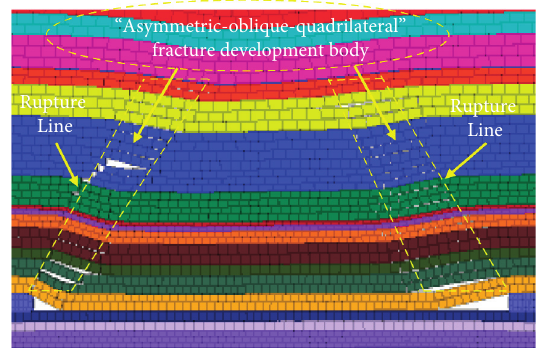
Figure 12: Mining to 110m.